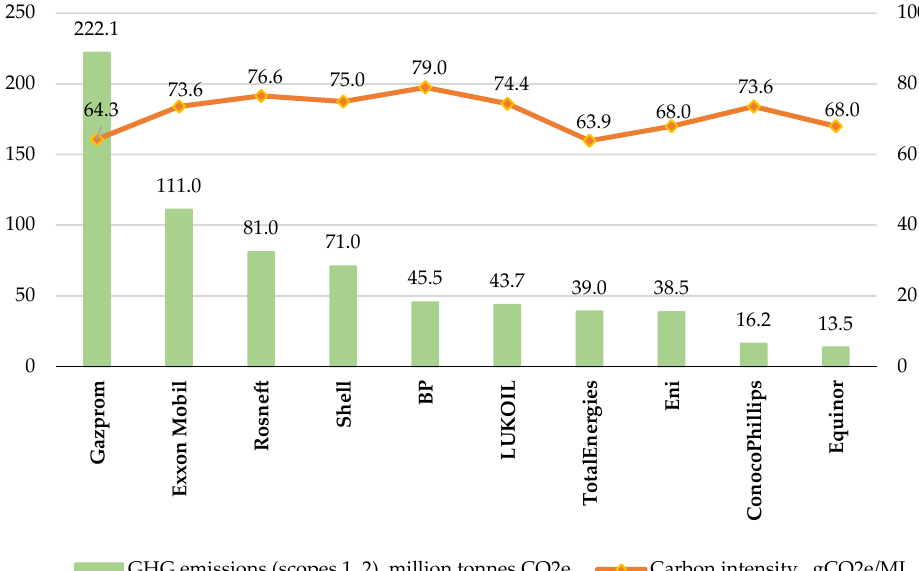
Figure 5. Greenhouse gas emissions and carbon intensity of oil and gas products in 2020. Source: Created by the authors using data from [65–69,71–76,87–89,91].